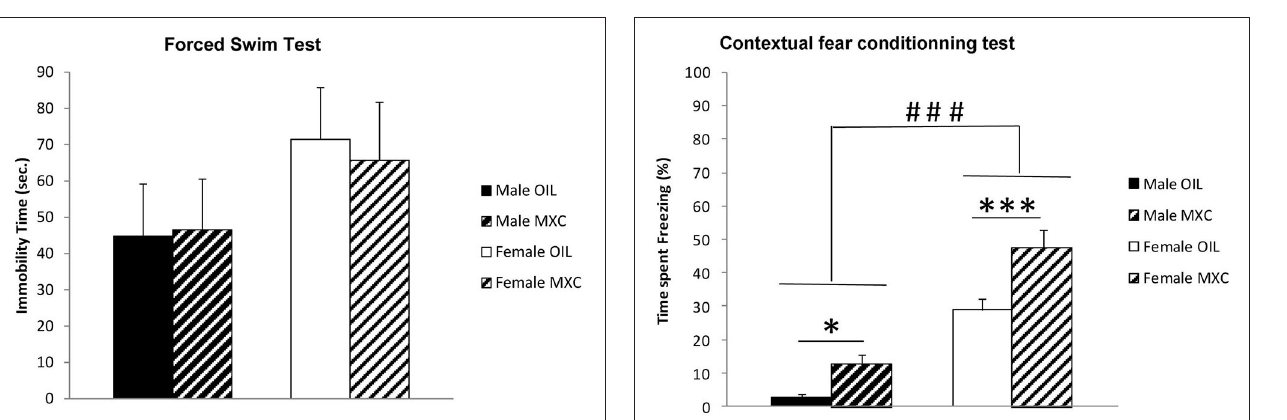
FIGURE 5 | Freezing behavior expressed as percentage of time spent freezing during the recorded period in contextual fear conditioning test. The percentage of time that the animal spent freezing revealed a significant effect of sex, with the females spending a greater percentage of time freezing than males. Percentage of contextual freezing was also significantly higher in MXC-treated mice compared to control. Data are expressed as mean ± SEM. * p < 0.05; *** p < 0.001; ### p < 0.001 in Females vs.